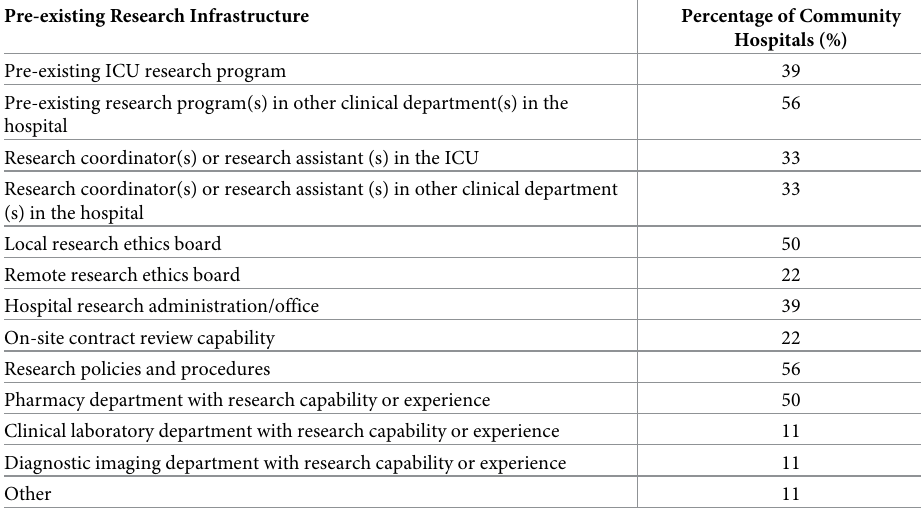
Table 1. Pre-existing hospital research infrastructure (N = 18).